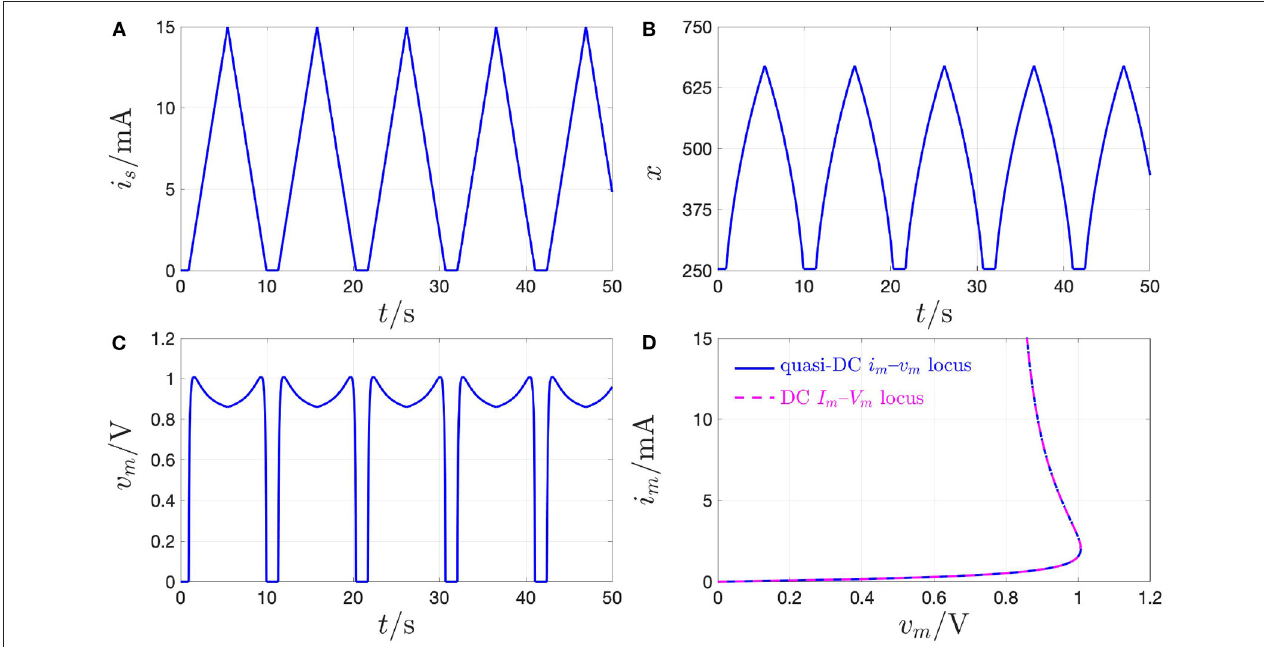
FIGURE 22 | Response of the micro-scale device to a quasi-static stimulation in current form. (A) Time waveform of a strictly positive purely AC slowly varying periodic triangular current signal i s , of amplitude ˆ i s 16mA and period T 9,s, inserted through the NbO threshold switch. (B) Time evolution of the memristor state = = in response to the quasi-DC stimulus in (A) from an initial condition x 0 set to 253.15. (C) Voltage falling across the memristor over time, as it follows from the quasi-static current excitation of the device. (D) Blue curve: Memristor AC current i m -voltage v m locus observed in the quasi-static test. Its qualitative and quantitative agreement with the device DC I m - V m characteristic, shown in magenta here, was expected from the study of section 2.3, since the whole NDR region of the memristor DC locus is stable under current